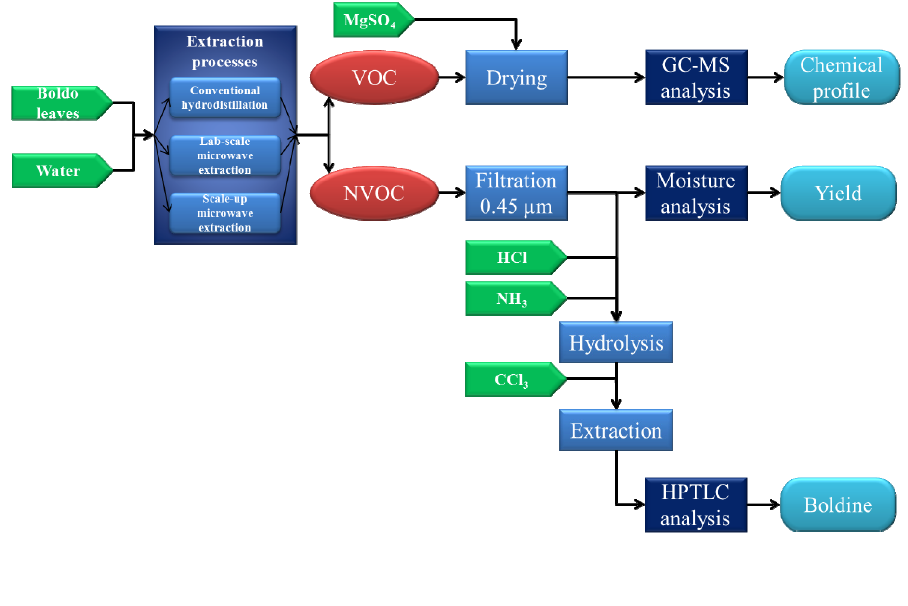
Figure 6. Protocol treatments of boldo